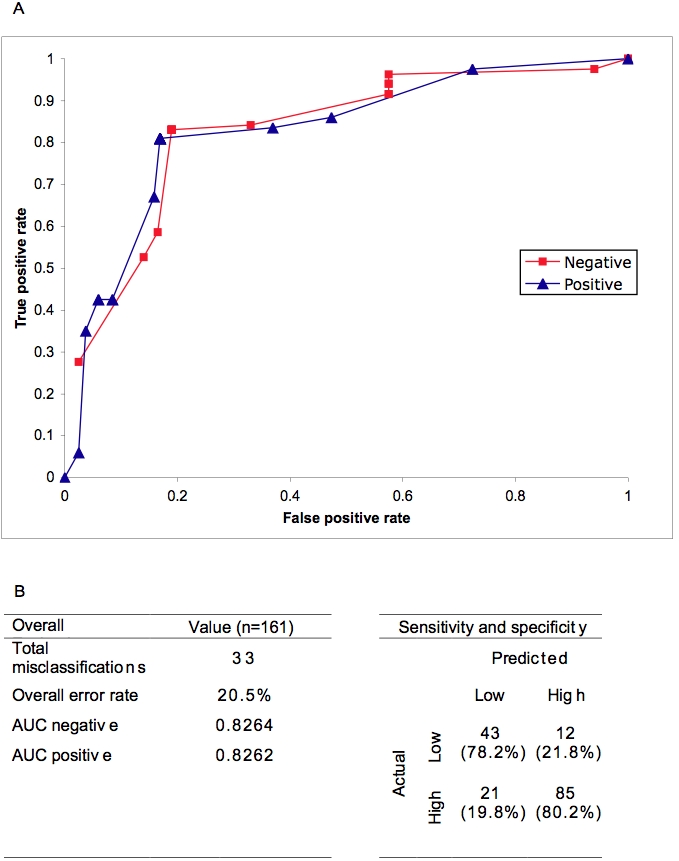
Performance of the decision algorithm for predicting severe dengue disease.A. Receiver operating characteristics (ROC) curve for the algorithm in predicting the development of severe disease among dengue cases. B. Summary of K-fold (k = 10) cross-validation for severity prediction algorithm with 2×2 analysis for the algorithm's sensitivity and specificity in predicting severe dengue disease.